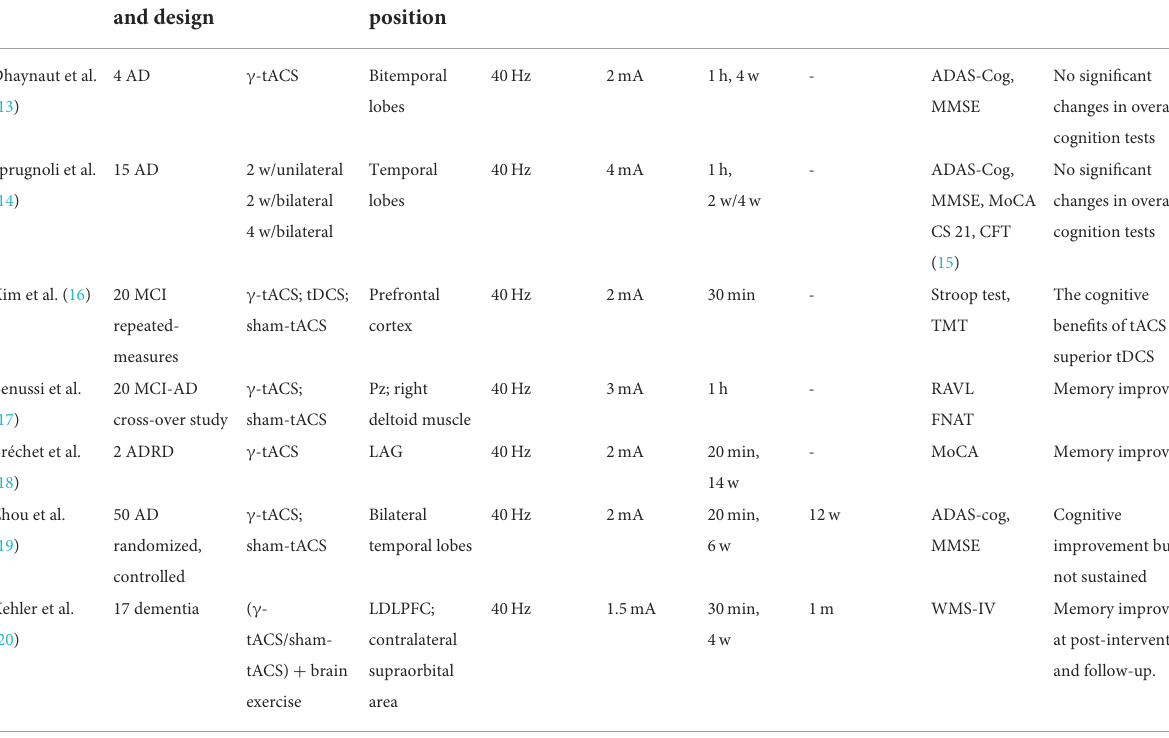
Assessment Outcome